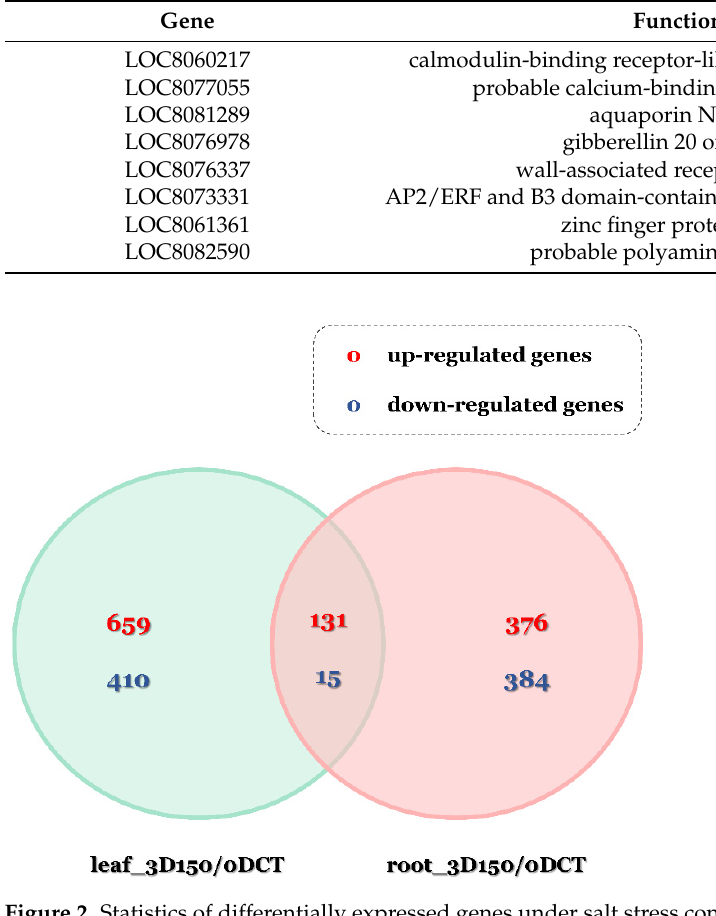
Figure 2. Statistics of differentially expressed genes under salt stress conditions and normal growth conditions (3D150; 150 mM NaCl treatment at 3 DAT, 3DCT; 0 mM NaCl treatment at 3